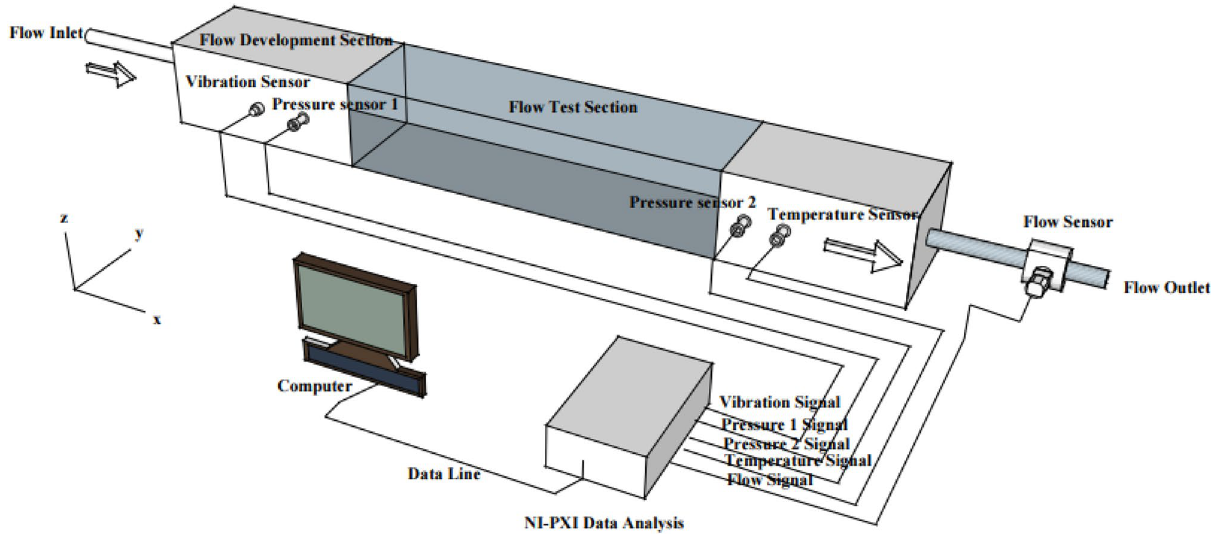
Figure 1. The schematic diagram of the experimental device of oil pulsation flow.